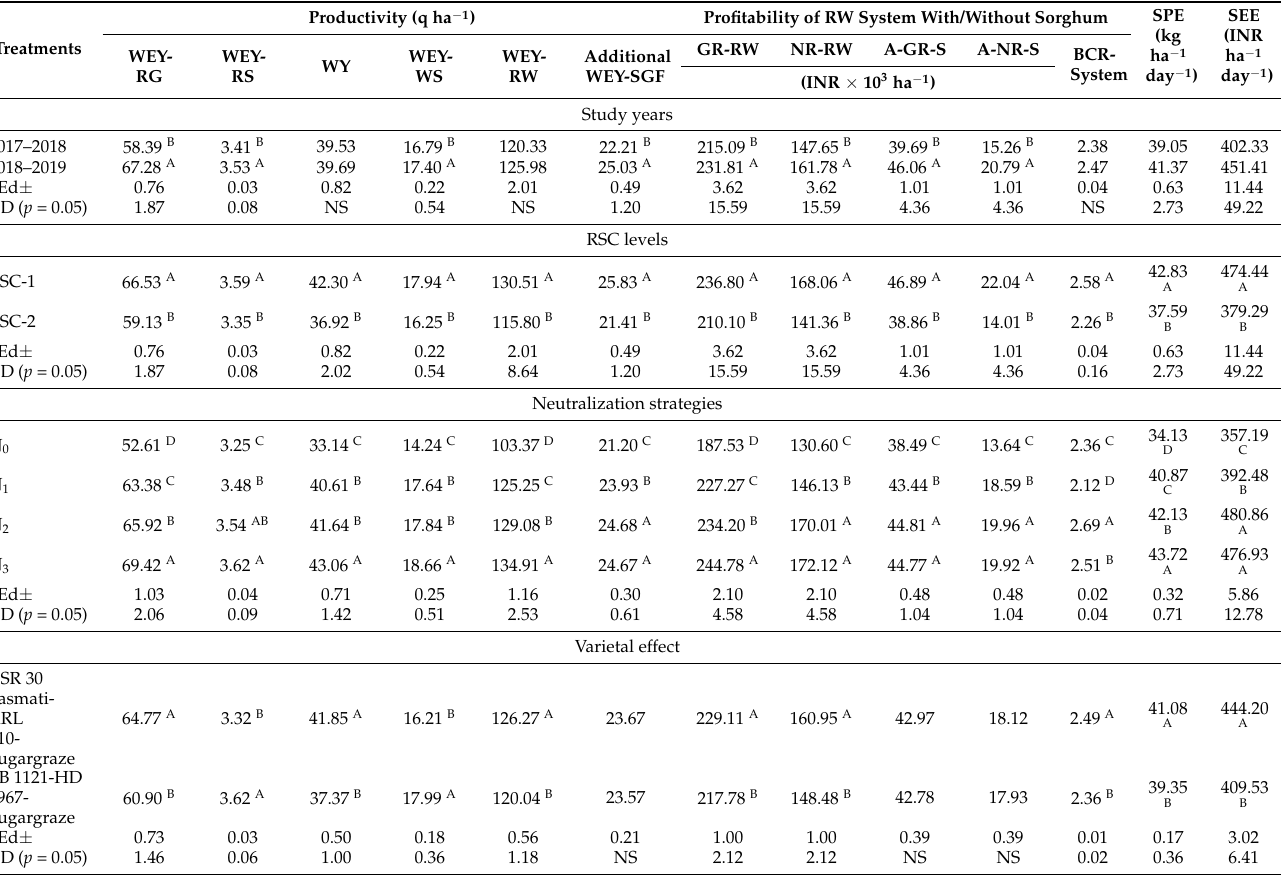
Figure 1. Interactive effect of neutralization strategies and RSC levels on green fodder yield (t ha − 1 ) of sorghum. Vertical bars labelled with various small letters vary substantially ( p ≤ 0.05) using the least significant difference test for mean separation; capped lines represent the standard error of the mean. Table 1. Productivity and profitability of rice-wheat system as influenced by study years, RSC levels, neutralization strategies and varietal sequences with/without sorghum